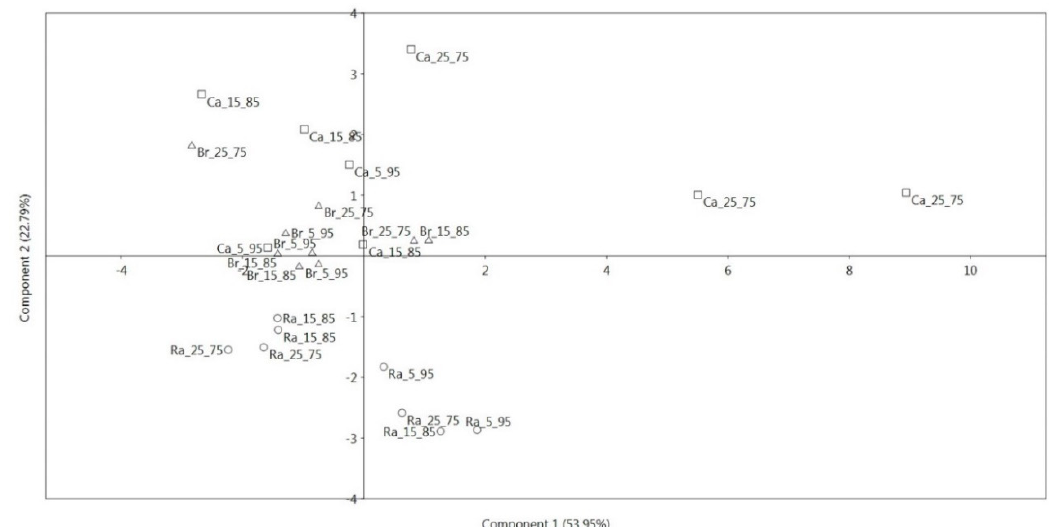
Figure 3. Score plot for principal components 1 and 2, describing variation in nutritional parameters of three Brassica genotypes of microgreens grown using three NH 4 :NO 3 molar ratios in the nutrient solution. For each genotype, 5_95, 15_85 and 25_75 indicate, respectively, the NH 4 :NO 3 molar ratios of 5:95, 15:85 and 25:75. Ra, micro broccoli raab; Br, micro broccoli; Ca, micro cauliflower.